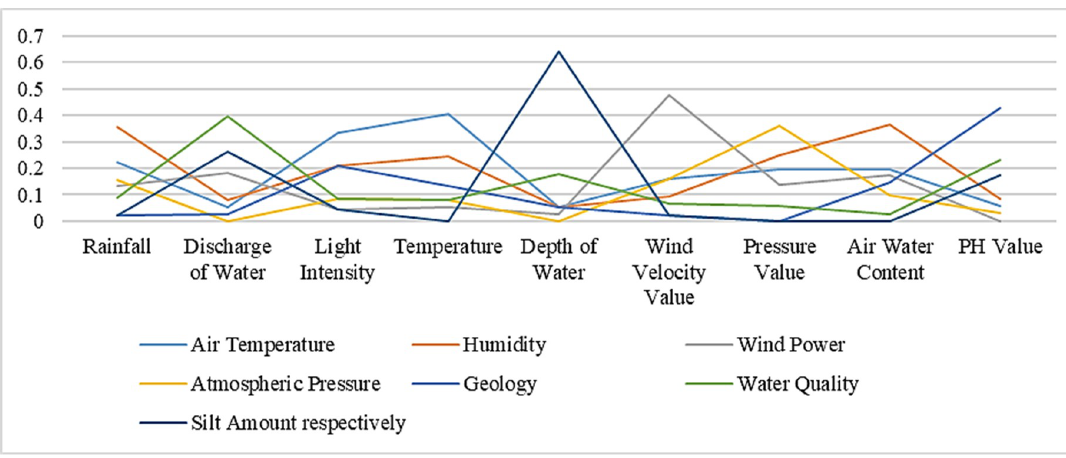
0 Table 7. Similarity results based on structural strategy. RF